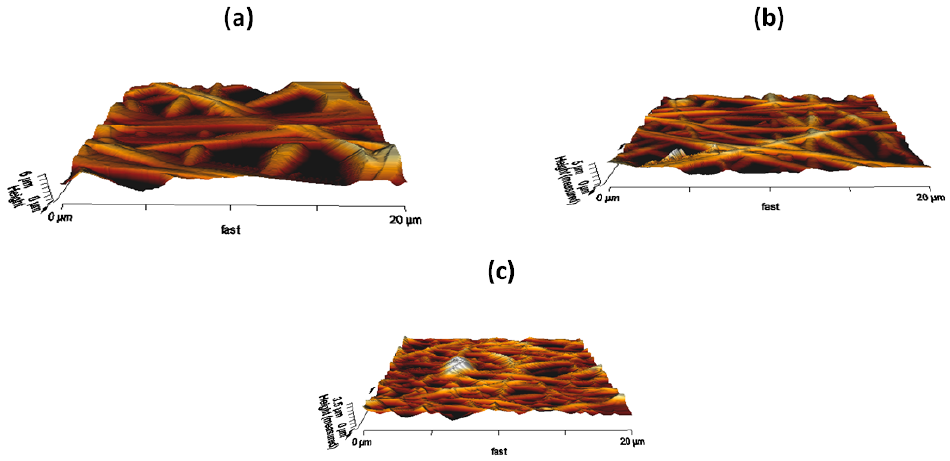
Figure 8. Atomic force microscopy (AFM) images of ( a ) PU, ( b ) PU/YY and ( c ) PU/YY/ZnNO 3.